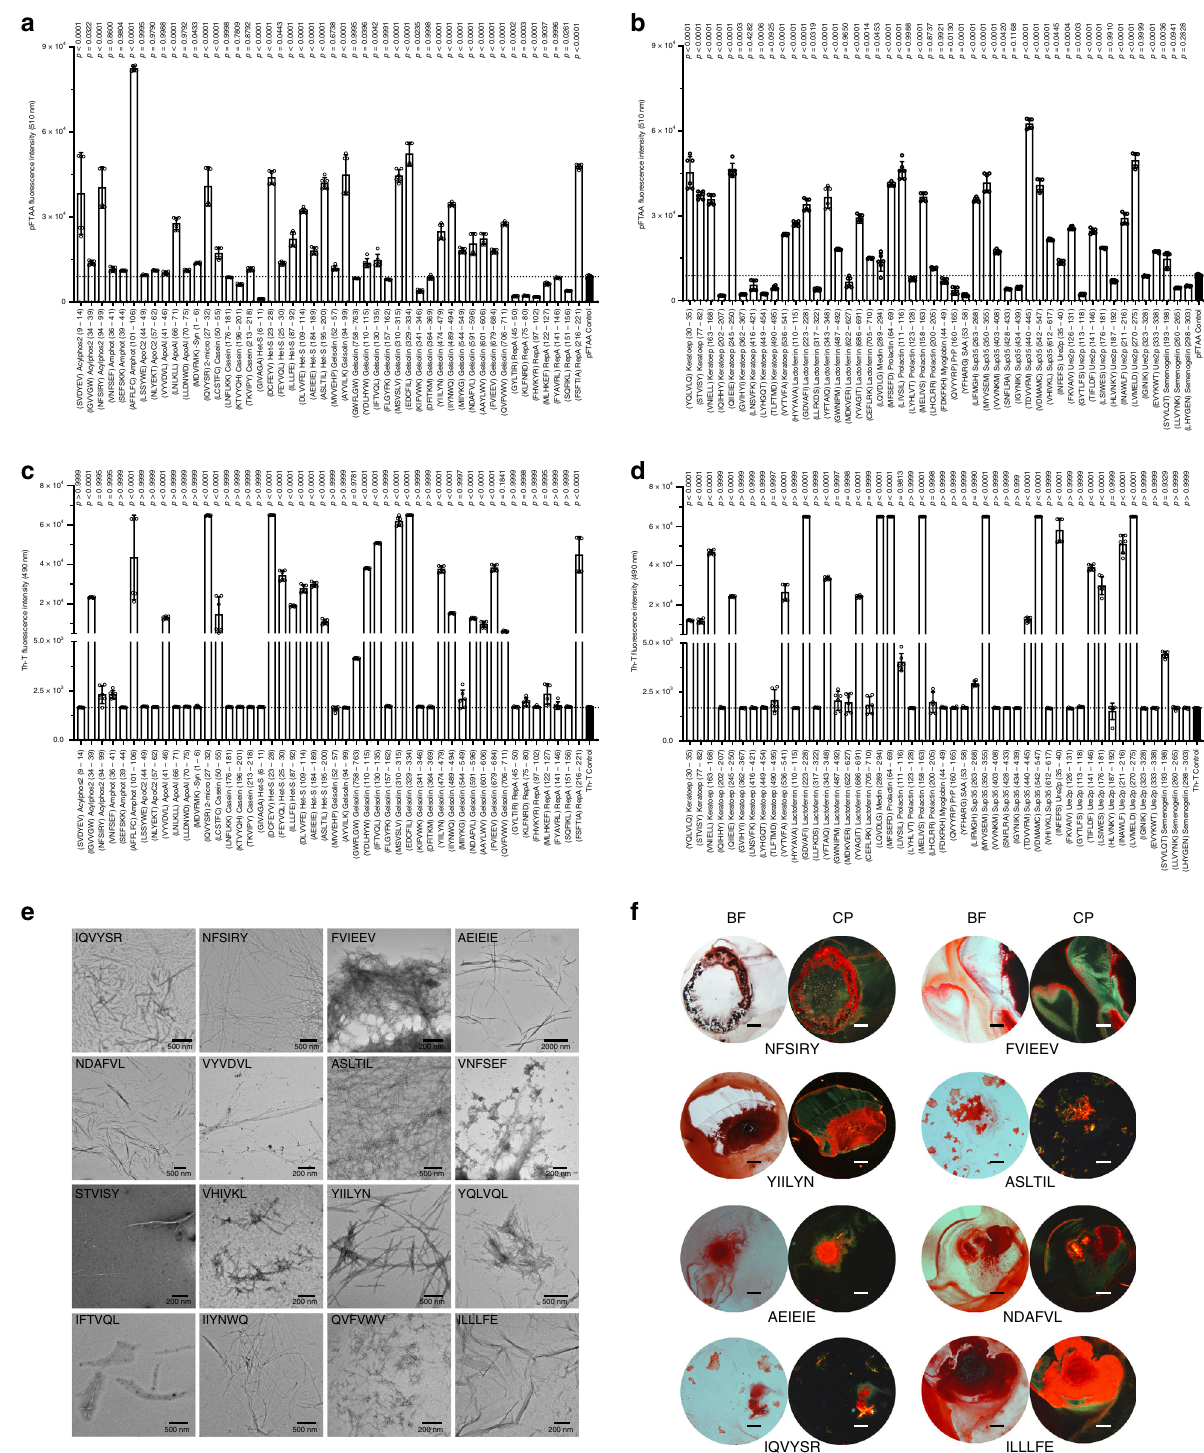
Fig. 4 Amyloid-forming properties of the peptide screen designed by employing Cordax. a and b Measured pFTAA and c and d Th-T fl uorescence of synthetic peptides following rotation at 200 μ M for 5 days. Data represents mean ± SD ( n = 6 independent experiments, statistics: one-way ANOVA with multiple comparison against the vehicle control). e Electron micrographs of amyloid fi brils formed by Th-T or pFTAA-binding peptides. f Suspensions of amyloid fi brils bind Congo red as displayed under bright fi eld illumination (BF) and exhibit typical for amyloids apple-green birefringence under crossed- polarised light (CP). Scale bars: 500 μ m. Source data are provided as a Source Data fi